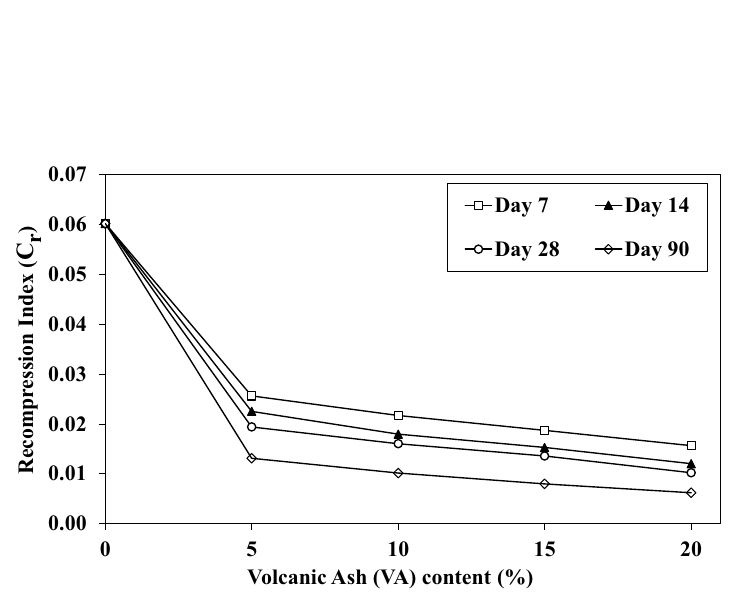
Figure 20. Influence of the volcanic ash (VA) content on the recompression index (C r ) for different curing